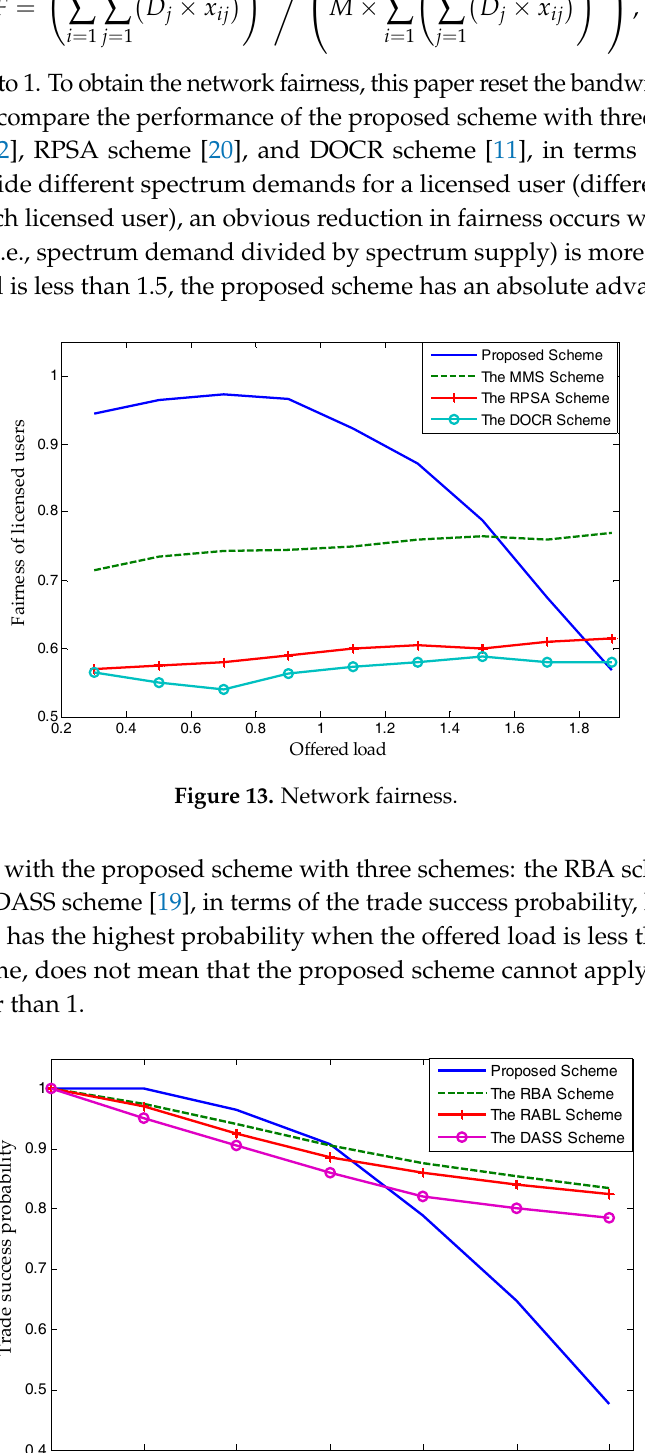
Figure 14. Trade success probability.